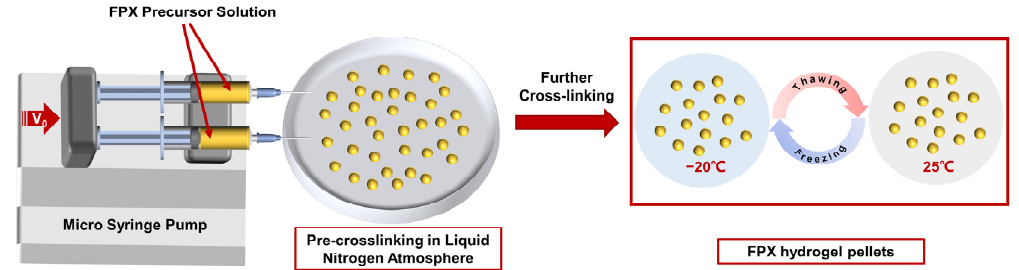
Figure 1. Schematic diagram of preparation process of FPX hydrogel pellets.